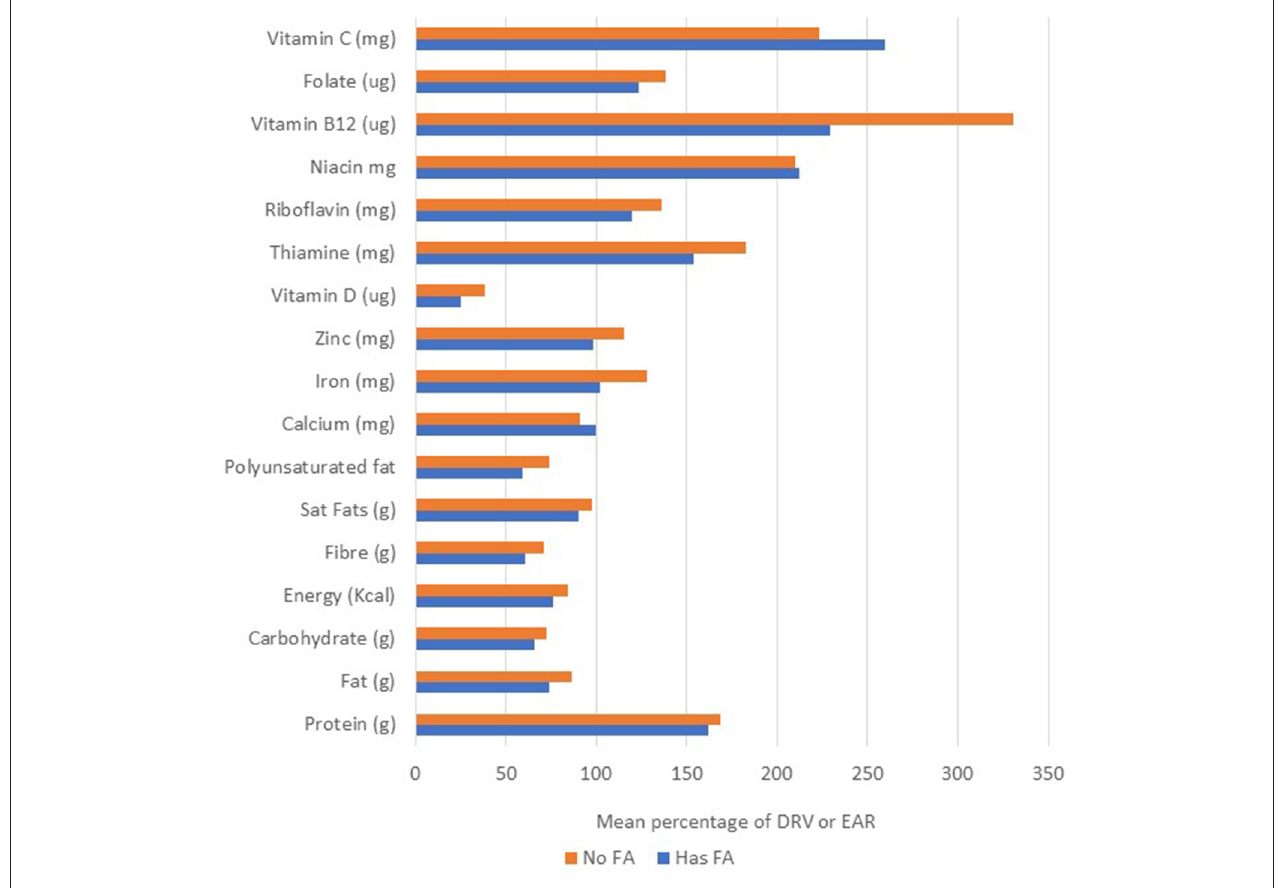
FIGURE 2 | Mean percentage dietary reference value for all